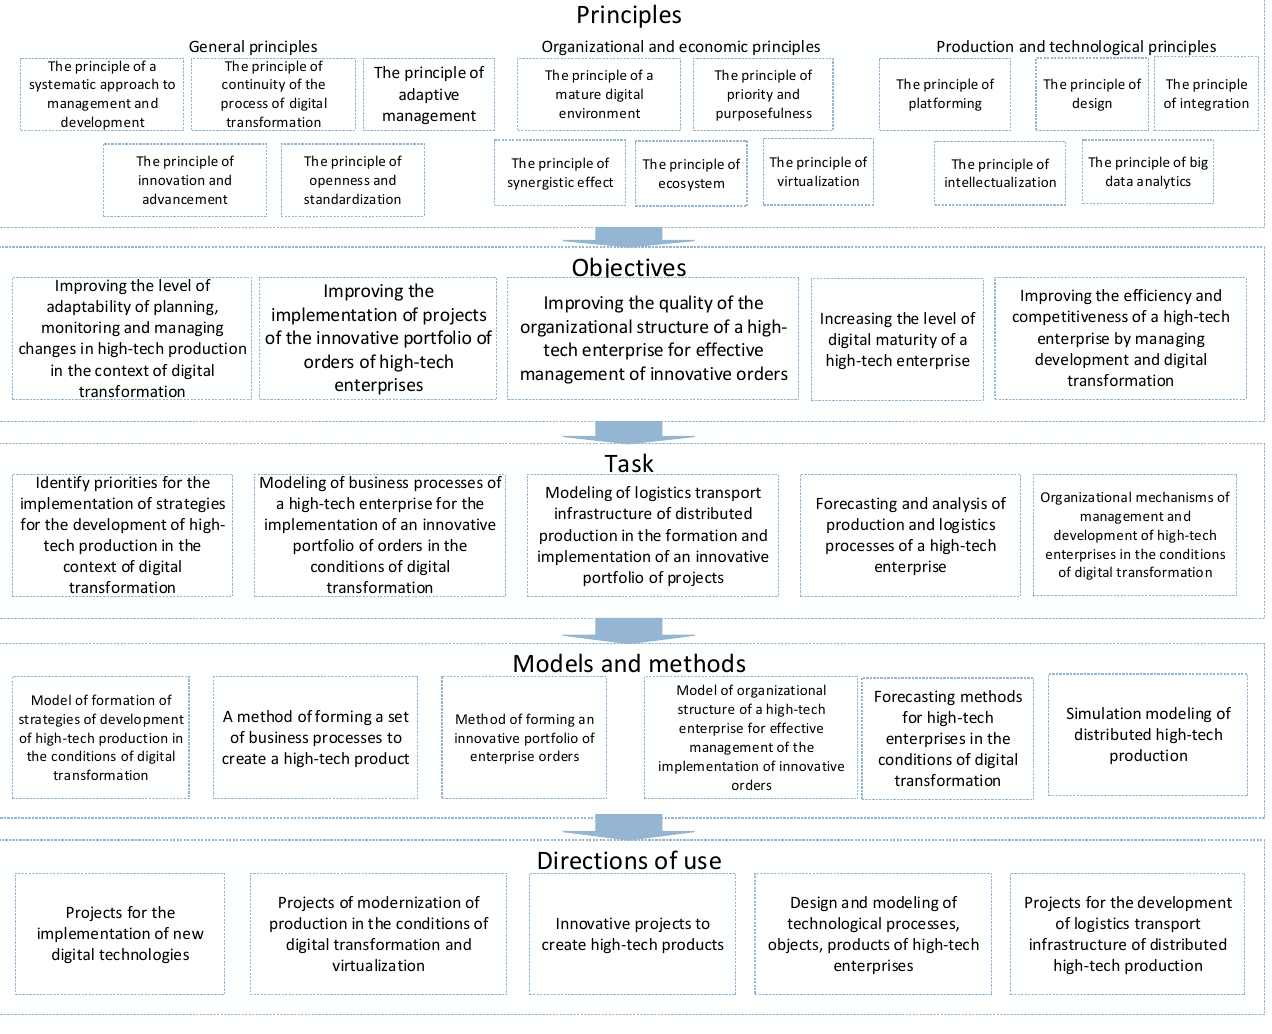
Figure 1. The structure of methodology of high-tech enterprise development management in the context of digital transformation. Source: own study.